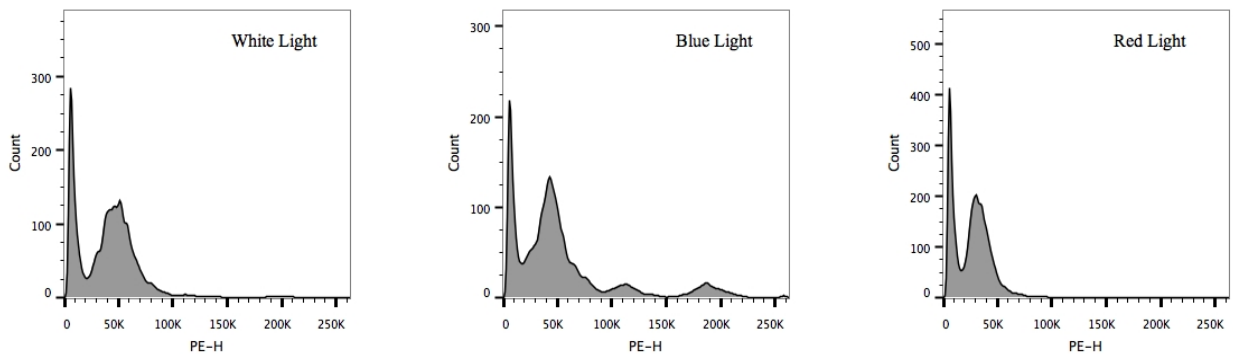
Figure 4. Cell cycle distribution of microalgal cells under white light, blue light, and red light under N ‐